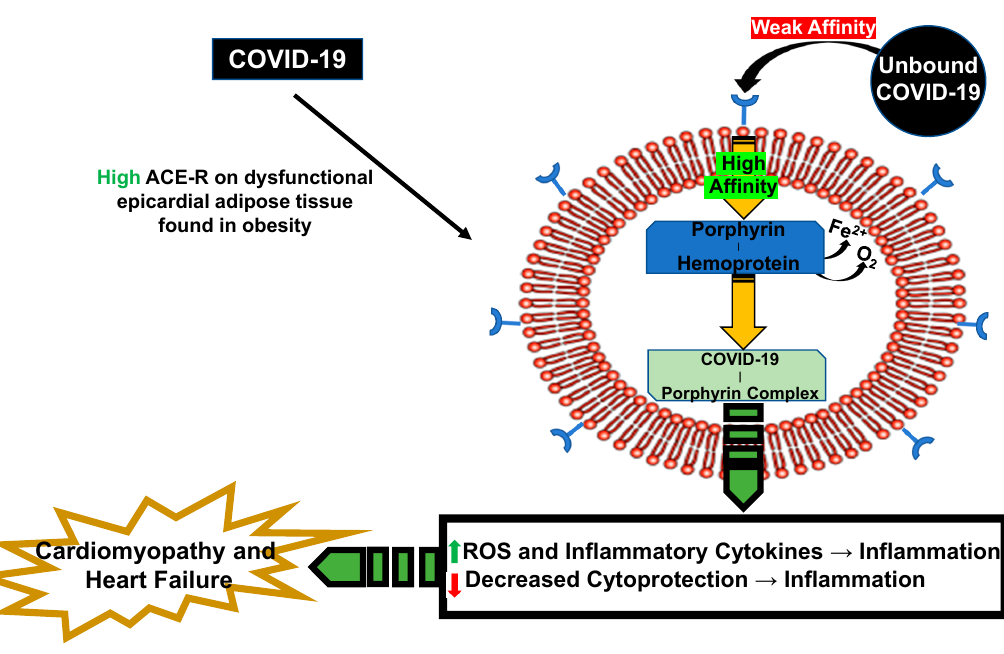
Figure 7. Schematic of increased ACE2R on white adipocytes in pericardial fat. There is increased baseline inflammation in obesity which is exacerbated due to COVID-19 infection. This can lead to subsequent cardiomyopathy and heart